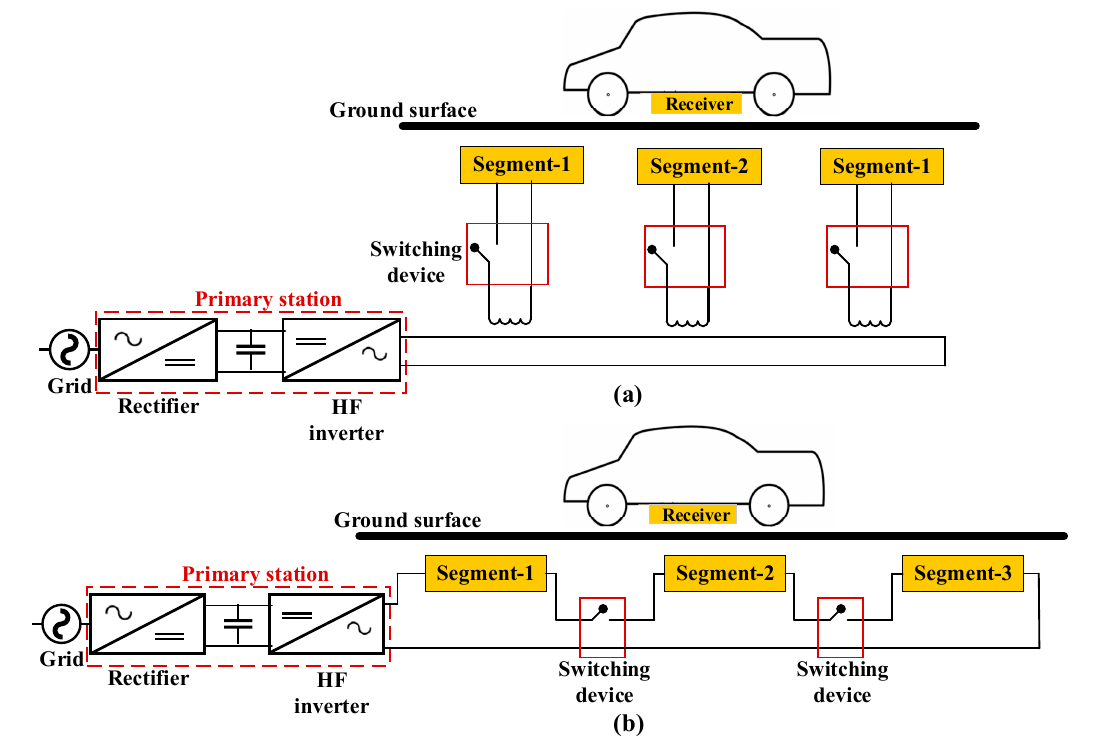
Figure 9. Additional supply arrangements for segmented transmitter of DIPT system that allow control of individual charging segments ( a ) using a common HF inverter with long magnetic path and ( b ) using a common HF inverter with series connection of transmitter segments.